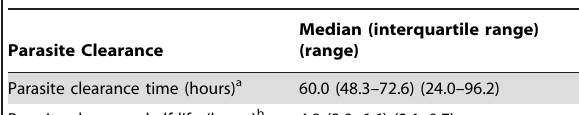
Table 2. Parasite